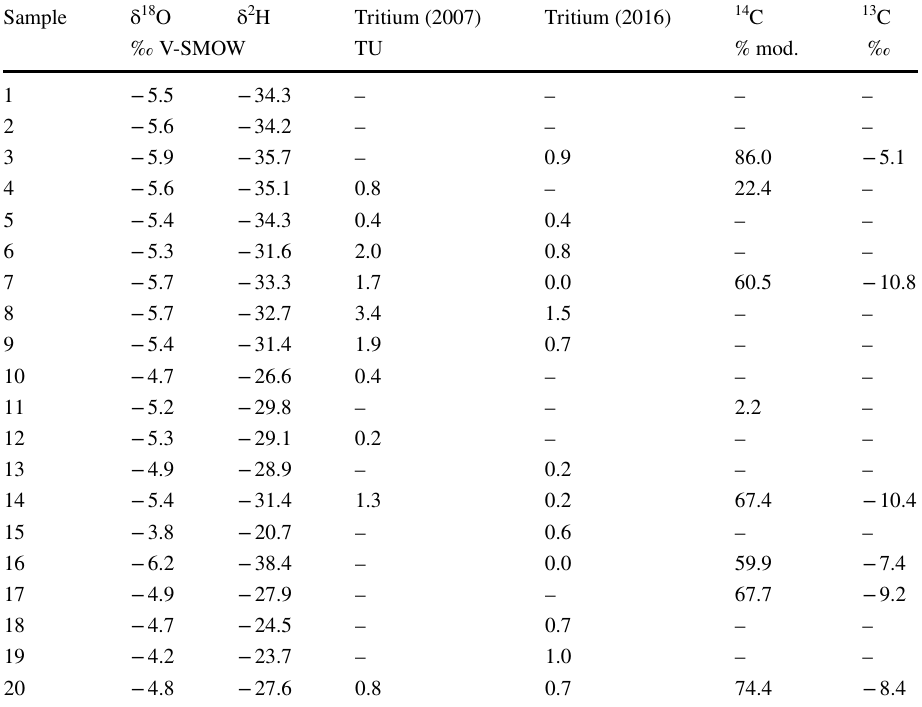
Table 3 Isotopic data of sampled groundwater